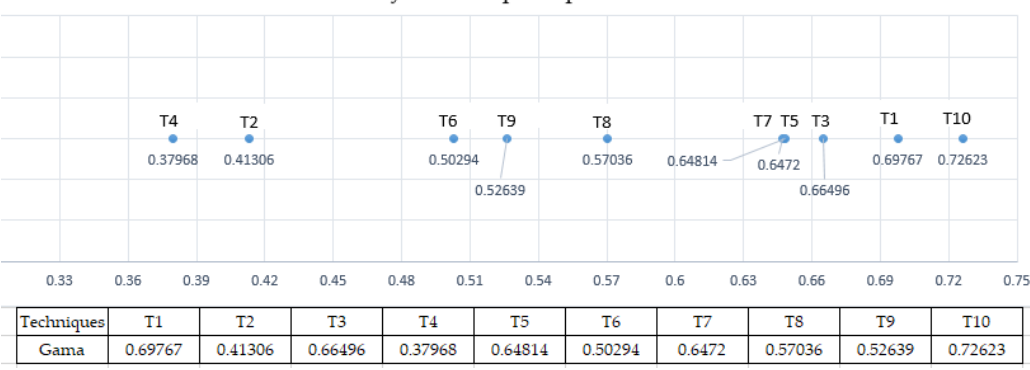
Figure 4. Priority of technique requirements.